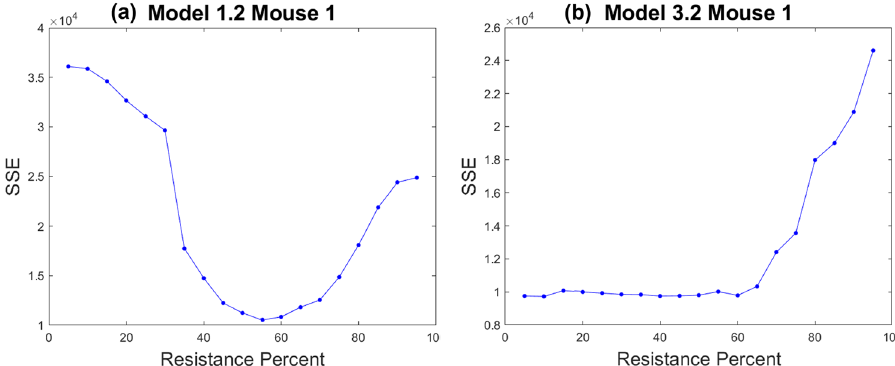
Fig. 6 Pro fi le likelihood curves of the initial resistance fraction for a representative mouse, Mouse 1. a The resistance fraction in Model 1.2 is practically identi fi able and places the optimal parameter at approximately 55%. b The resistance fraction in Model 3.2 is not practically identi fi